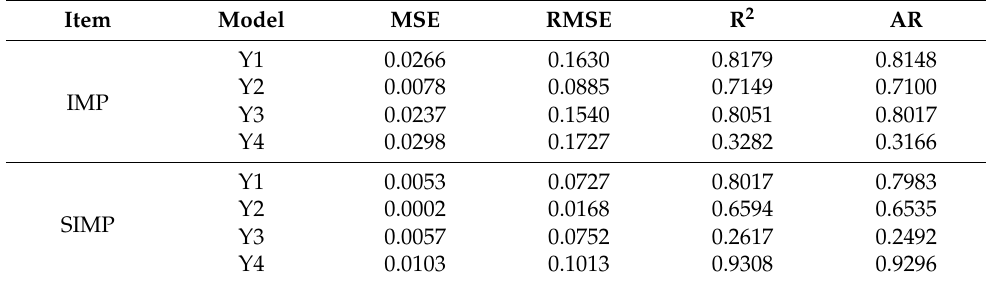
Table 10. Validation evaluation of the integration of multiple parameters